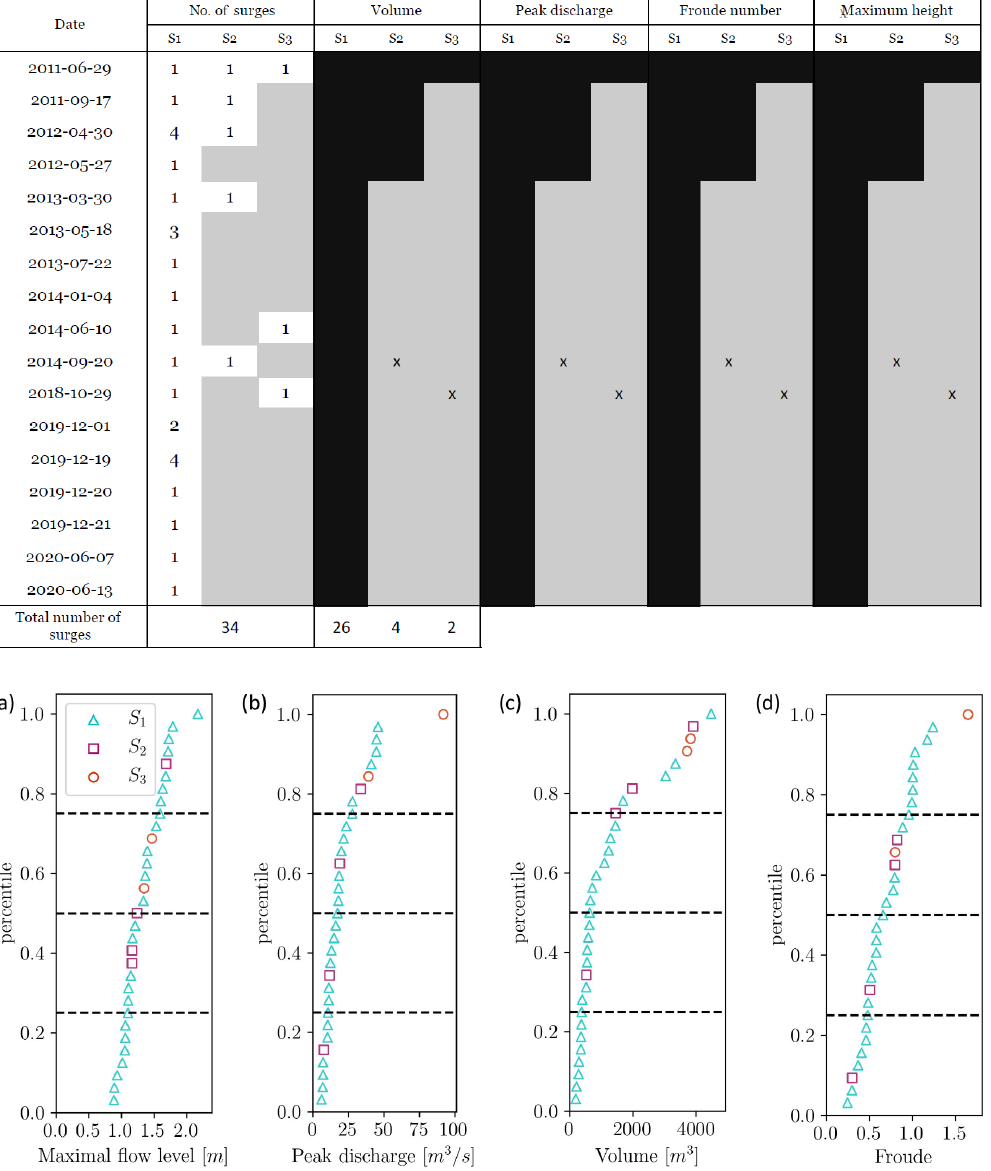
Figure 6. Cumulative density functions of hydraulic values of interest: (a) maximal flow level, (b) peak discharge, (c) volume and (d)